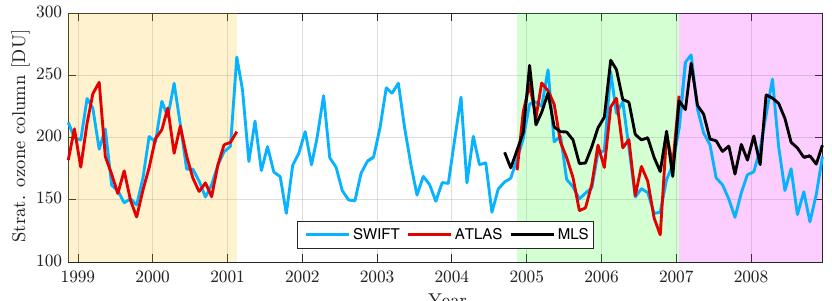
Figure 7. Monthly mean values of the stratospheric ozone column (15–32km) over Potsdam (52.4 ◦ N, 13.0 ◦ E). The bright blue line shows the continuous 10-year simulation with SWIFT. The orange and green shaded patches are the periods from which the training data originate, and hence ATLAS data are available (red line). Beginning in fall 2004, Aura MLS data are available (black line) and during the pink period SWIFT and MLS are compared outside the training data period.